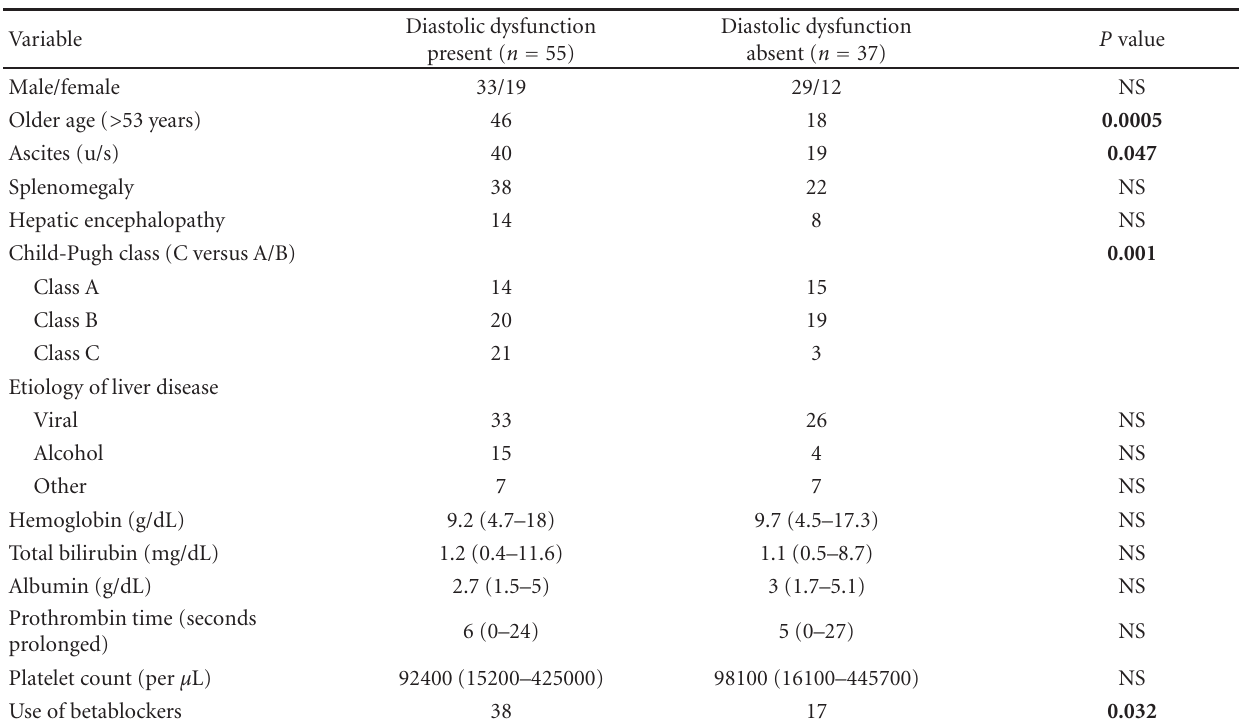
Table 4: Relationship of various parameters with regard to the presence or absence of diastolic dysfunction on univariate